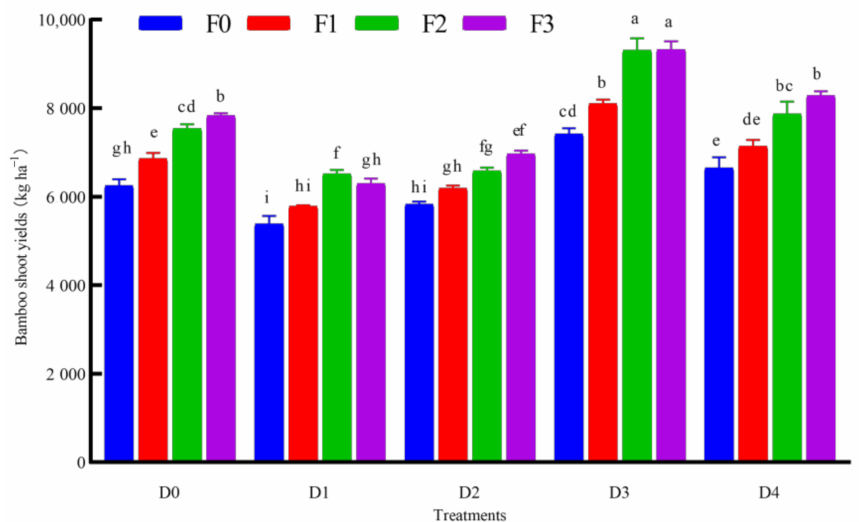
Figure 1. The bamboo-shoot yields of C. pachystachys forests by treatments. Error bars indicate standard error ( n = 3). Different lowercase letters show significance at the 0.05 level according to Bonferroni’s